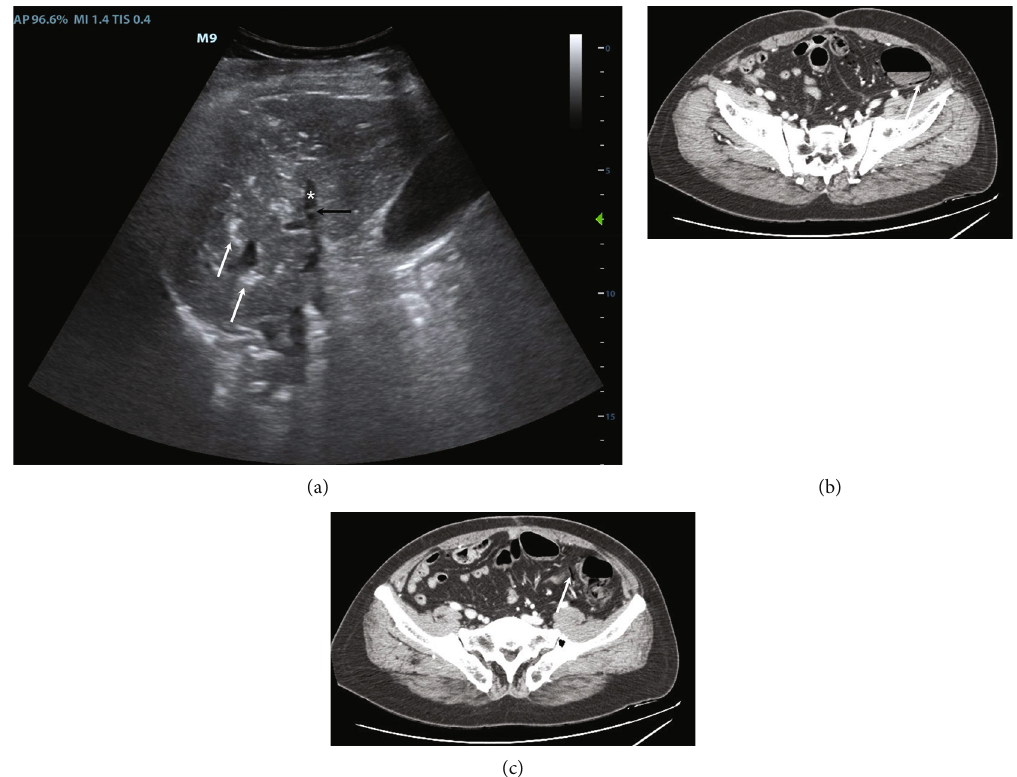
Figure 2: POCUS and CTA of case 2. (a) POCUS shows a right portal branch (asterisk) with some air bubbles into the lumen (black arrow). White arrows indicate some air in intrahepatic portal vessels. (b) CTA showing pneumatosis intestinalis (white arrow). (c) CTA shows the air fl owing within the intestinal vessels (white arrow), as it is drained from the pneumatosis intestinalis, that will reach the portal vein. POCUS stands for point-of-care ultrasonography; CTA stands for computed tomographic